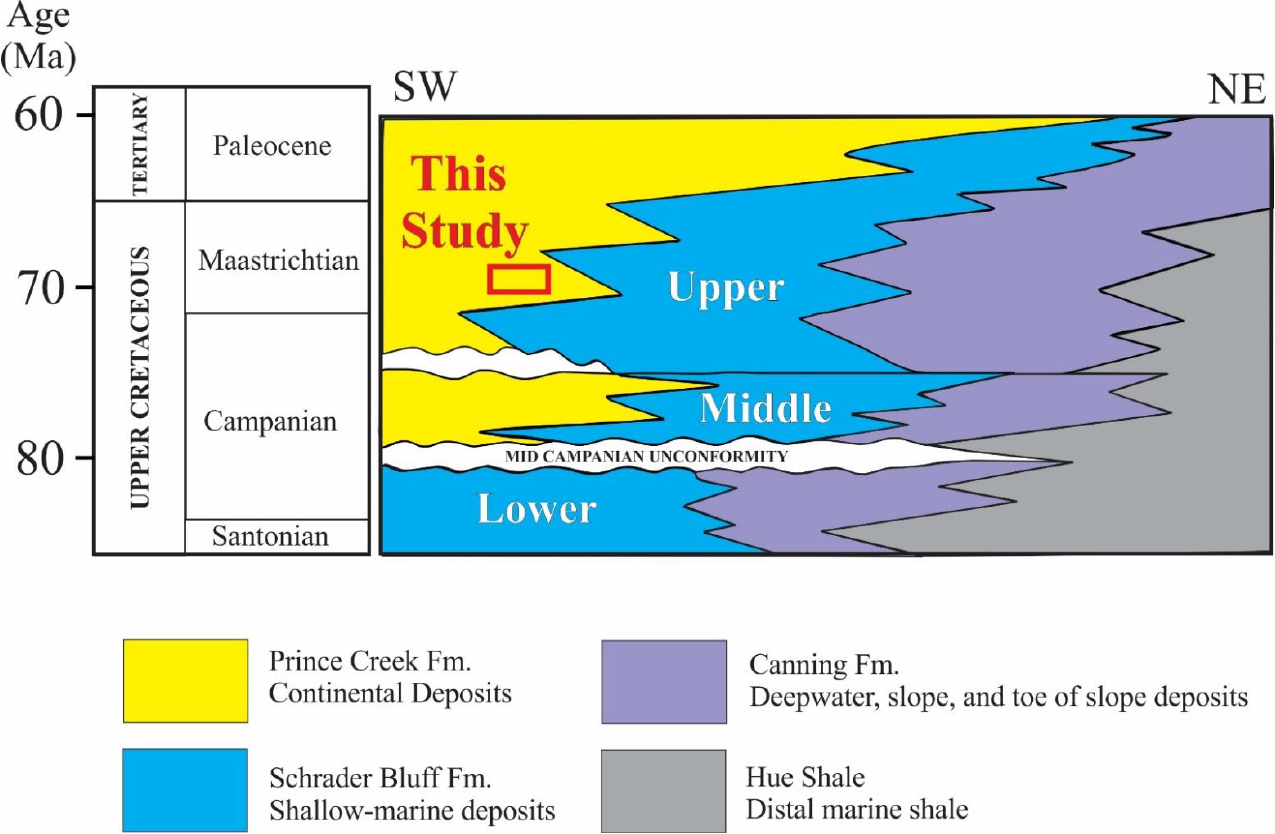
Figure 1. Generalized chronostratigraphic diagram of the North Slope, Alaska. Solid box indicates stratigraphic position of study area. Revised from [23 – 26].